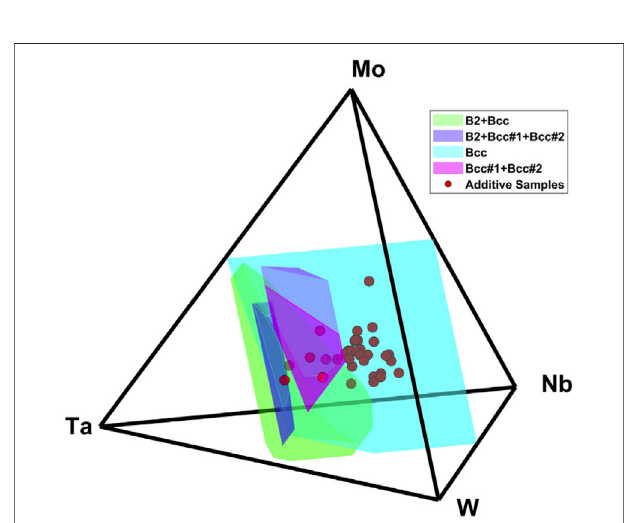
FIGURE9 | Quaternary phase diagram ofMoNbTaW family of refractory MPEAs. The illustration highlights the stable phases at 300 ° C spanning the numerous possible compositions of this family (Moorehead et al.,